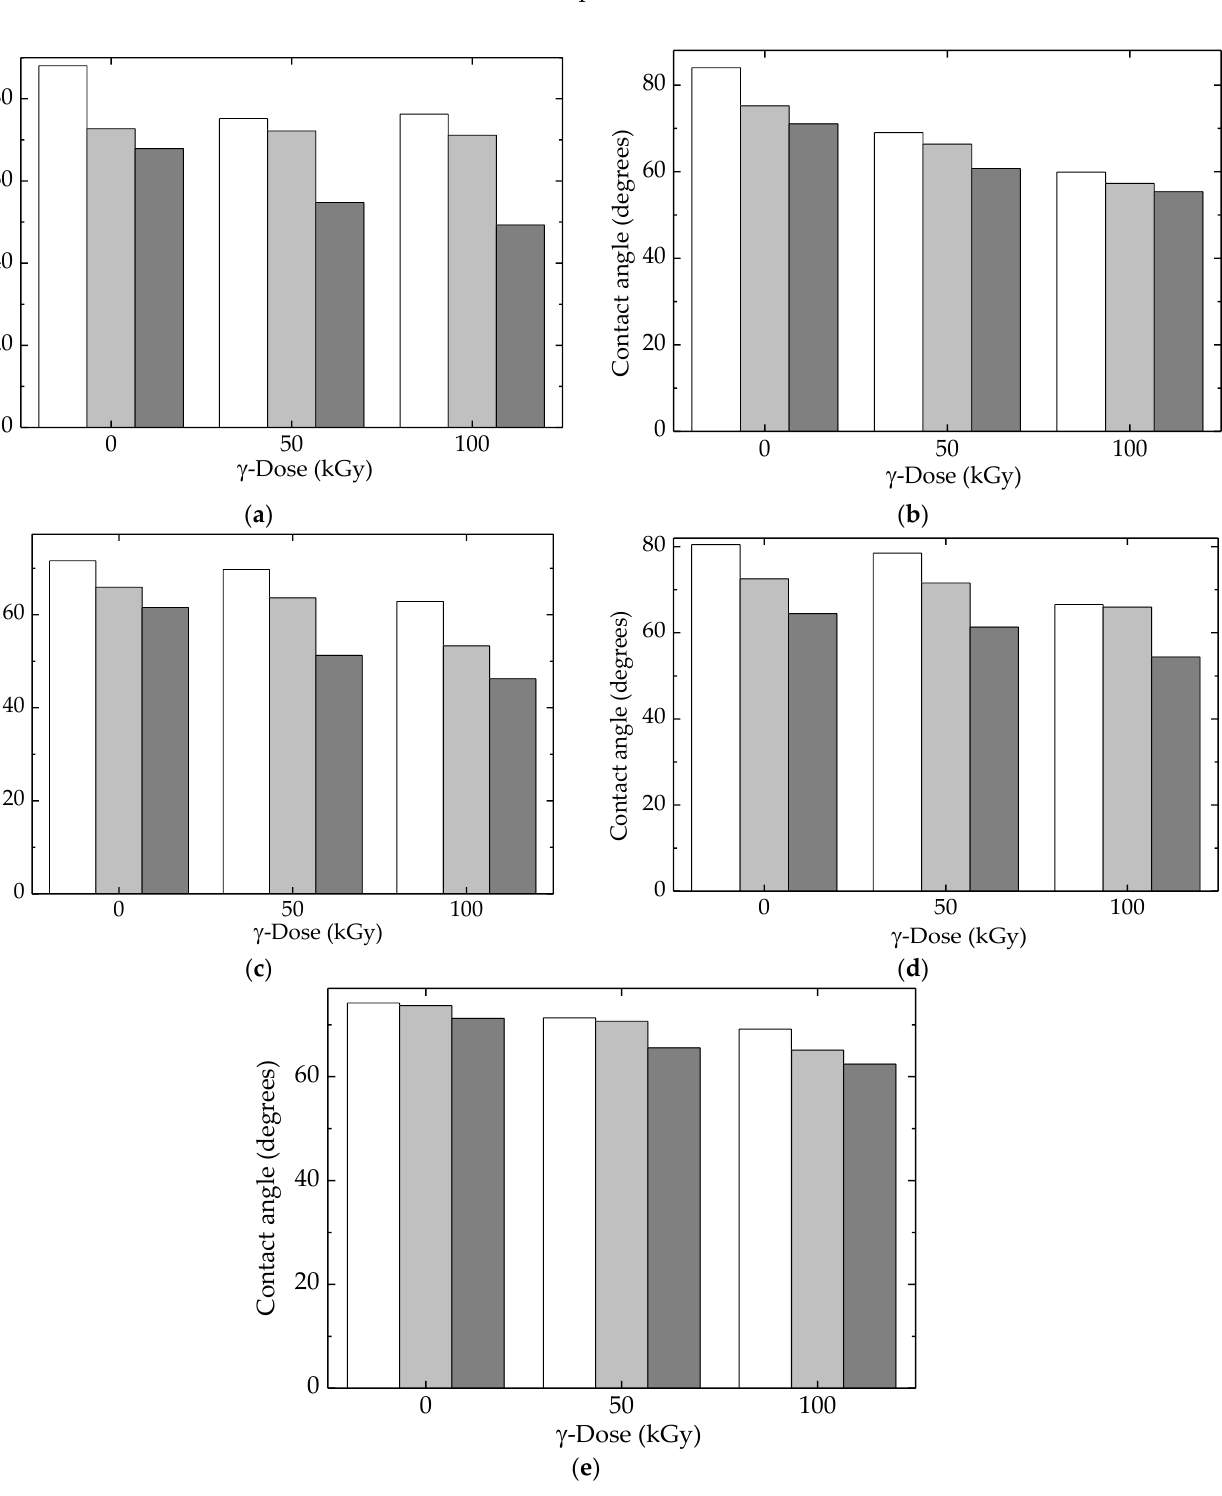
Figure 11. Contact angles calculated for all the investigated samples with (white) water, (light grey) glycerol, and (dark gray) ethylene glycol. ( a ) LDPE/UHMWPE, ( b ) LDPE/HAp, ( c ) LDPE/HAp/RM, ( d ) LDPE/UHMWPE/HAp, ( e ) LDPE/UHMWPE/HAp/RM.